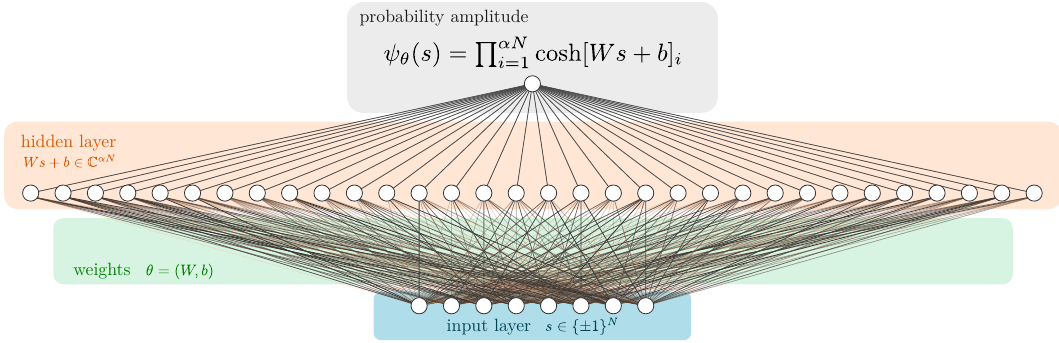
Figure 2: Restricted Boltzmann machine architecture used as a variational quantum state with N visible units corresponding to the lattice size and a hidden unit density α . A detailed description of the ansatz is given in Appendix